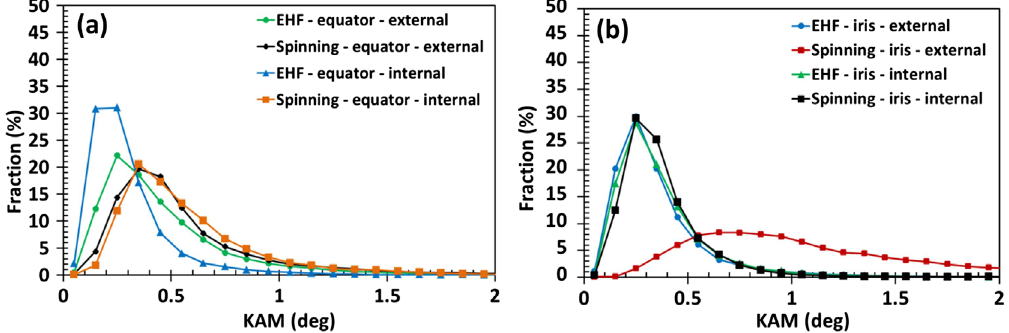
FIG. 18. Local misorientation distribution at the external and internal surfaces for specimens extracted from half-cells formed by EHF and spinning: (a) specimens obtained from equator; (b) specimens obtained from iris.